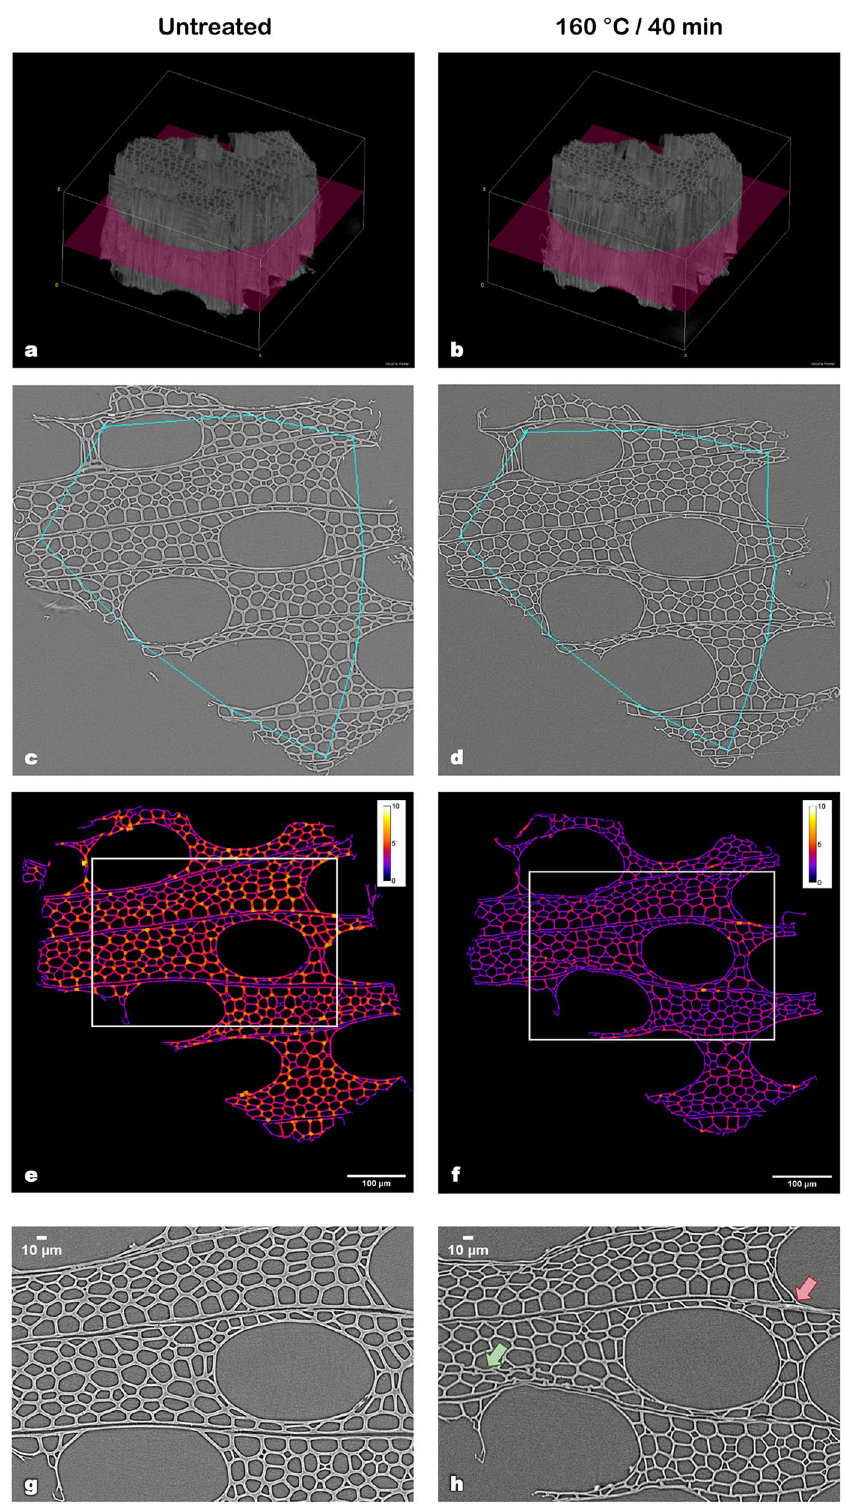
Figure 5. X-ray nano-tomography images of the same sample in its untreated state and after hydrothermal treatment at 160 °C for 40 min. ( a , b ) 3-D reconstructions of the sample, highlighting the virtual sections observed in figures ( c – h ) [obtained with the help of ImageJ v1.52i software; imagej.nih.gov/ij/]. ( c , d ) The chains of points used to determine the shrinkage of the sample. ( e , f ) The calculated thickness of cell walls throughout the slices (in µm) [obtained with the help of ImageJ v1.52i software; imagej.nih.gov/ij/]. ( g , h ) Highlights of cell wall collapse (green) and cell detachment (red), extracted from the regions within the white rectangles in ( e , f